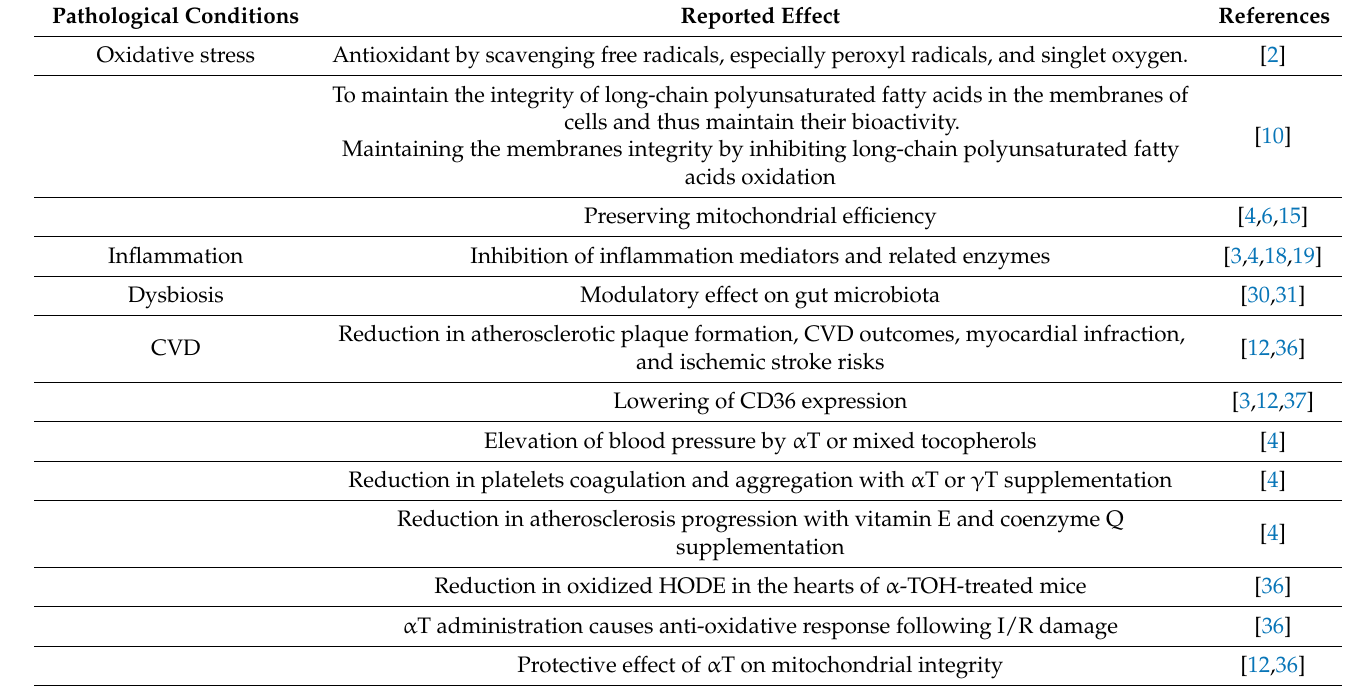
Table 1. Summary of the known and potential vitamin E effects on some non-communicable patho- logical